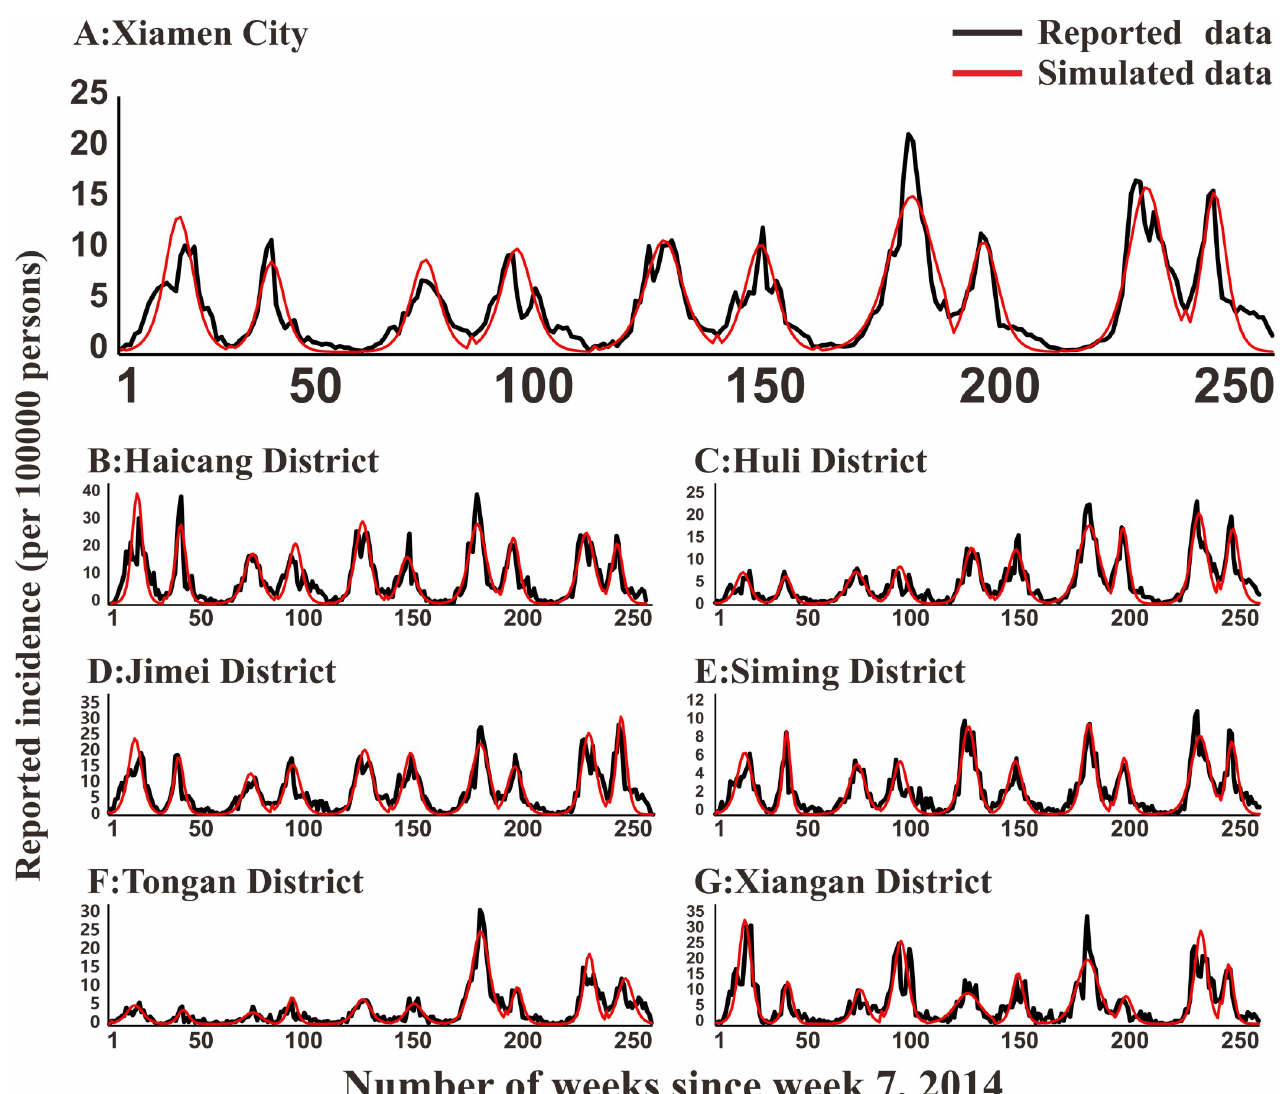
Fig 8. Epidemics of HFMD and LDE model fittings within Xiamen City and its 6 districts. (A: Xiamen City; B: Haicang District; C: Huli District; D: Jimei District; E: Simin District; F: Tongan District; G: Xiangan District).